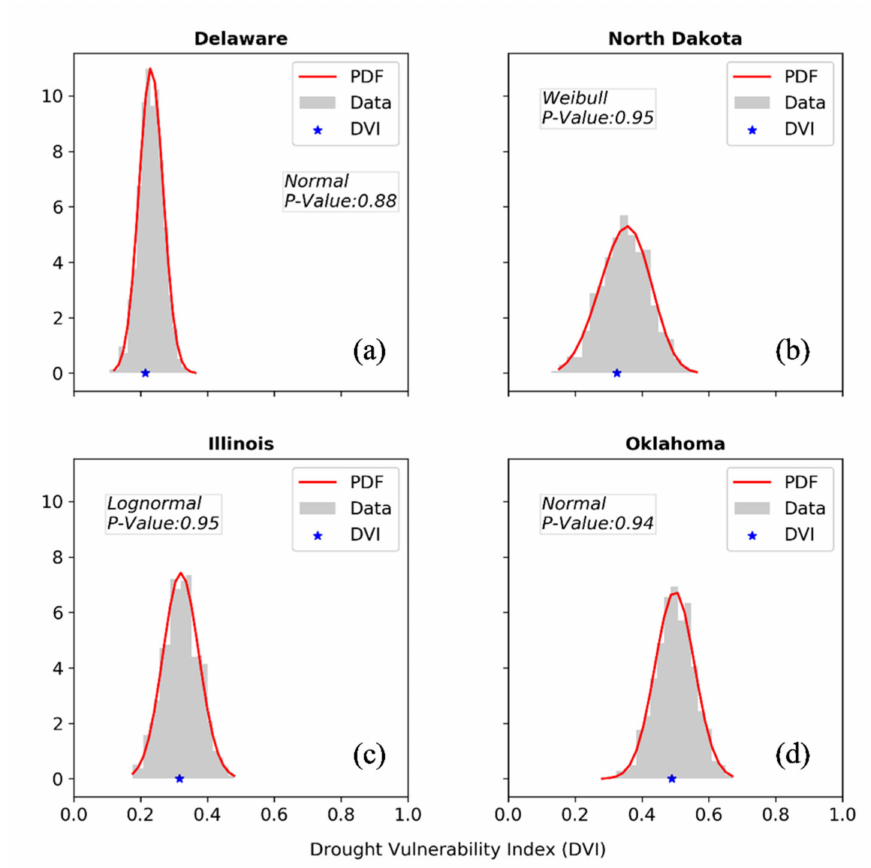
Figure 5. The probability density functions (PDFs) of Drought Vulnerability Index (DVI) (red line) for ( a ) Delaware, ( b ) North Dakota, ( c ) Illinois, and ( d ) Oklahoma states together with their deterministic DVI (blue point). The most appropriate distribution corresponding to the p -value of its K-S test is reported for each